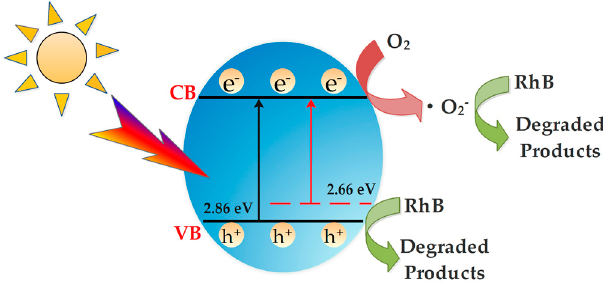
Figure 16. Proposed photocatalytic mechanism of S-doped Bi 2 MoO 6 sample.